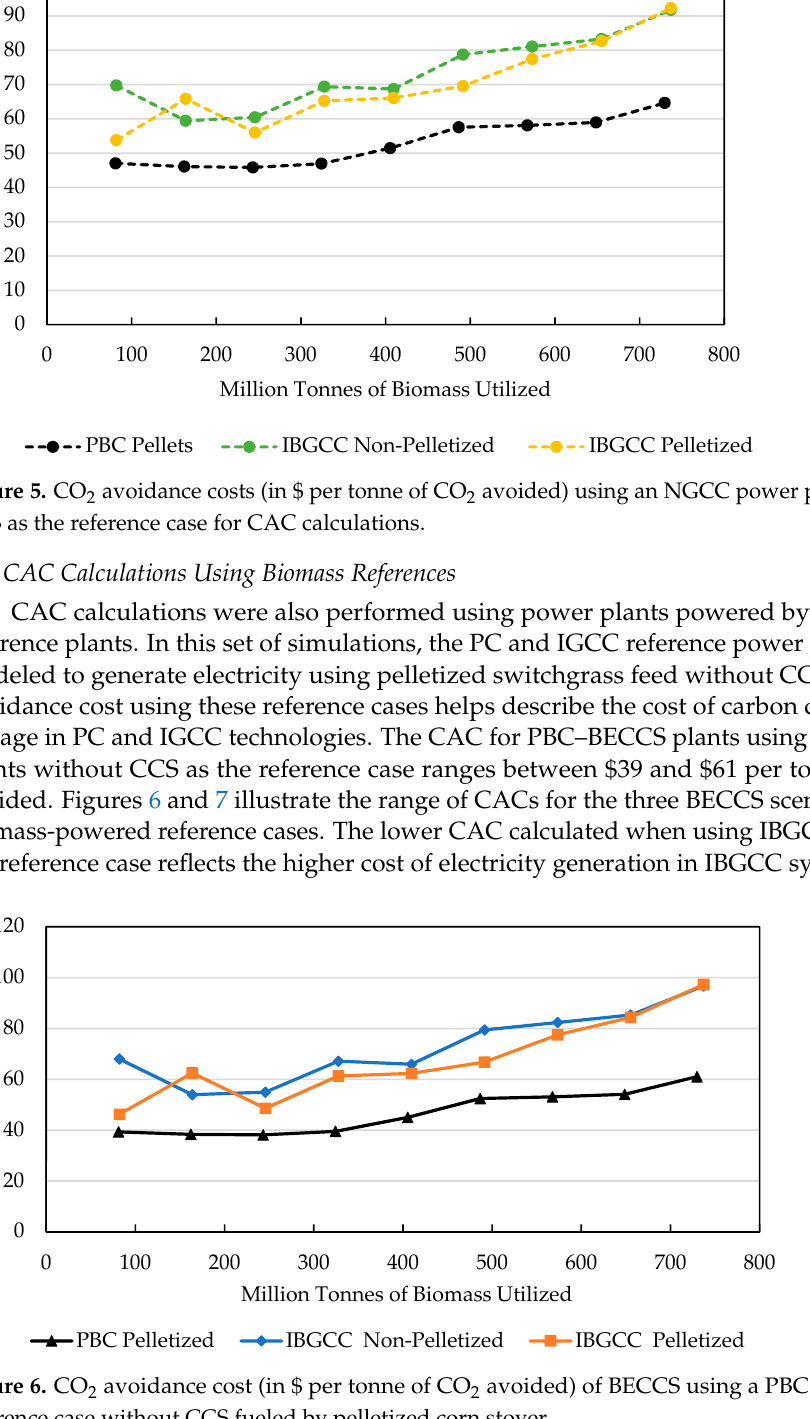
Figure 7. CO 2 avoidance cost (in $ per tonne of CO 2 avoided) of BECCS using an IBGCC power plant fueled by corn stover- derived syngas as a reference case. 3.5. Corn Stover Co-Firing Literature research indicates that a corn stover feedstock can be co-fired up to 30 weight percent in coal power plants with little technical modification [30]. The avoidance costs of co-fired power plants are explored to understand the effect of the CO 2 credit ex- perienced by a biomass co-fired feedstock. Biomass feedstock, for the purposes of CO ₂ accounting, can be considered to have negative emissions, because unlike coal, plants se- quester atmospheric CO ₂ at much faster rates. Figures 8 and 9 present the CAC of co-fired corn stover power plants. The CAC for a 30% corn stover co-fired plant is found to range